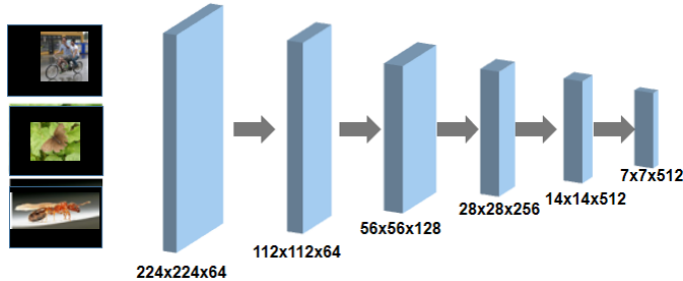
Figure 3. The designed architecture of the feature encoder module.